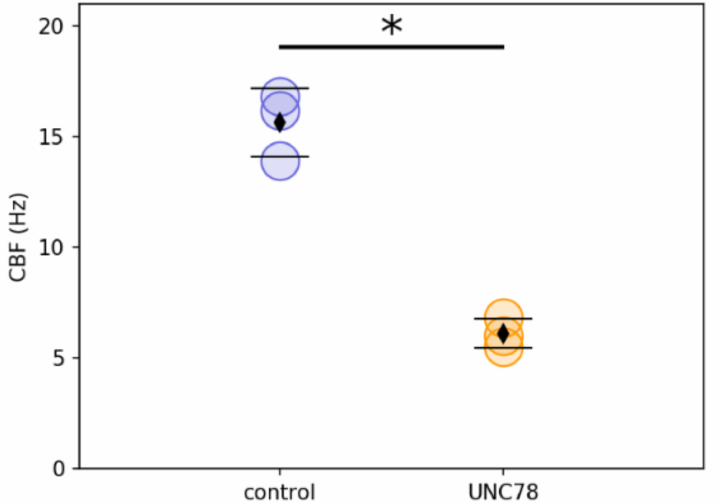
Figure 2. Ciliary beat frequency in ALI cultures of healthy control HNE cells and UNC78 HNE cells. Each point represents the average of 3–4 cultures from a separate experiment. Diamond symbol, the mean; error bars, std dev.; *, p < 0.001 by Student’s t -test. Blue symbols = control; orange symbols =